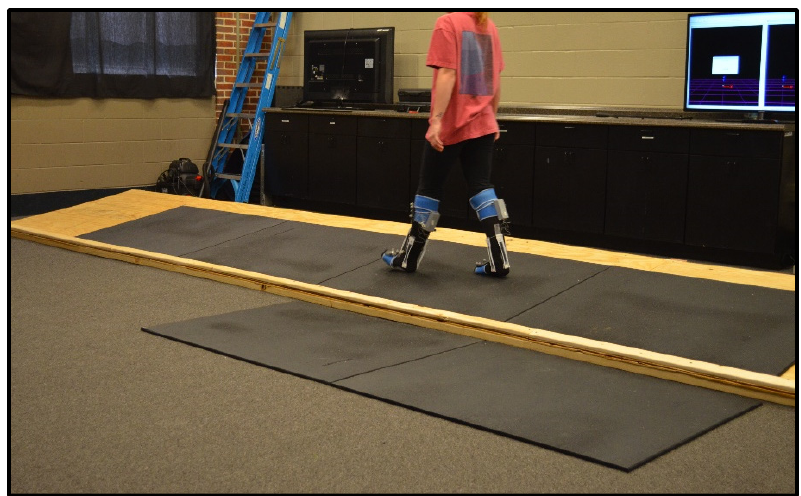
Figure 7. Participant walking across a tilted surface platform (TSP).